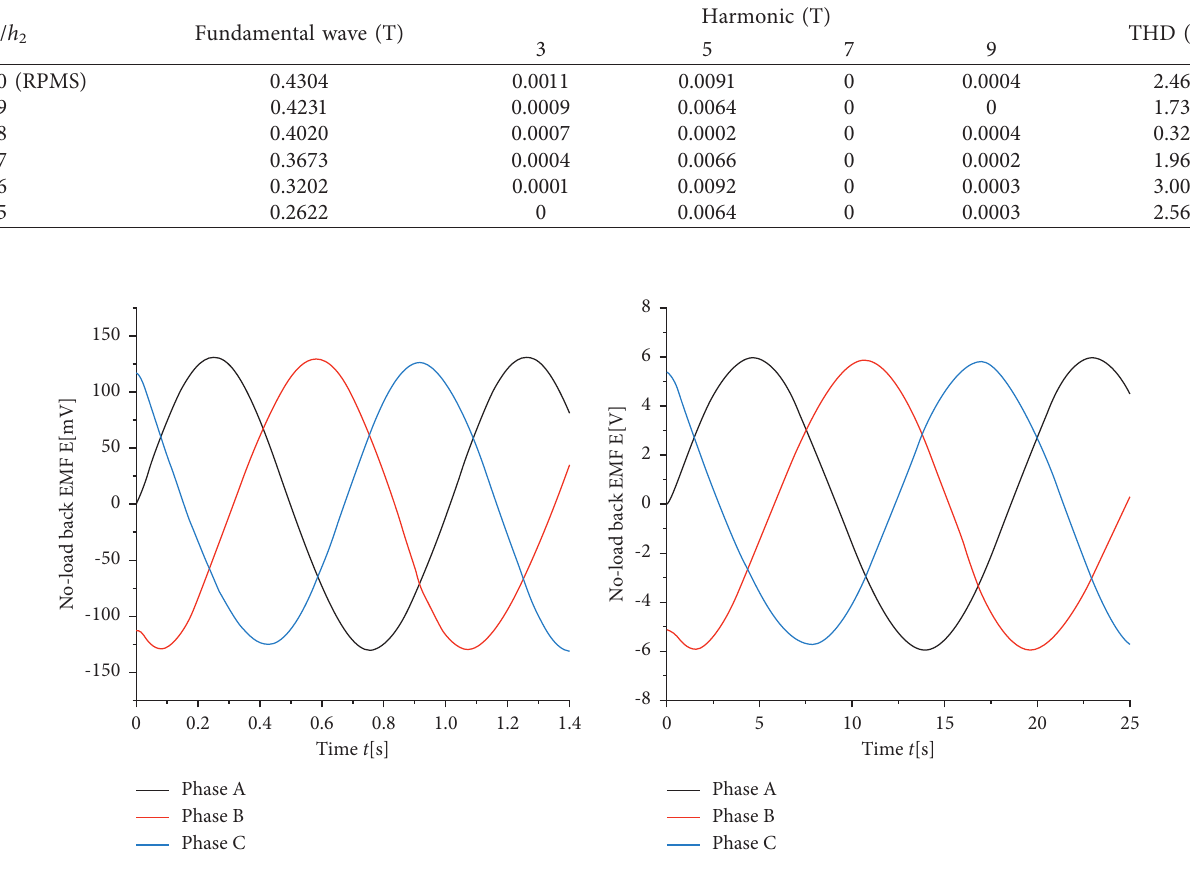
Table 1: Relationship between h 1 / h 2 and fundamental wave and harmonic of radial AGMF.